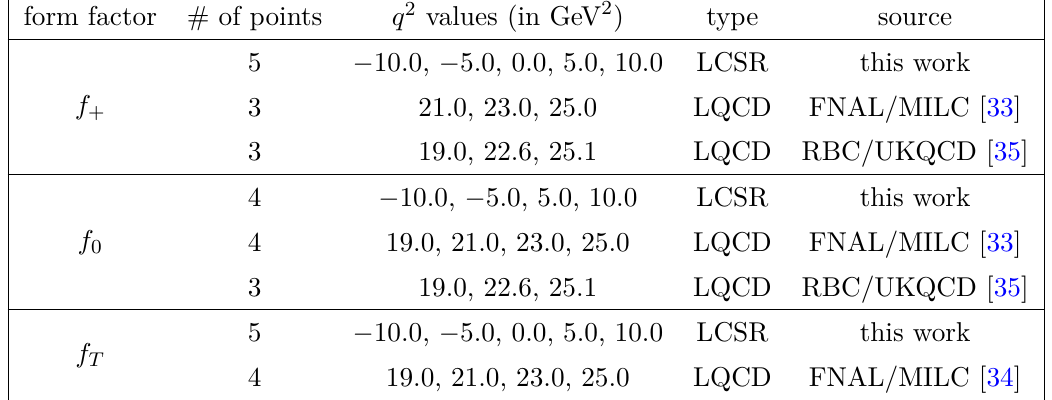
Table 4 . A complete list of the data points for the 3 transition form factors used in the combined fit. is manifestly fulfilled. This replacements requires the removal of the row and column associated with b + from the correlation matrix, reducing the number of free parameters to 3 three. Hence, the maximal number of independent pseudo data points from FNAL/MILC is now also limited to